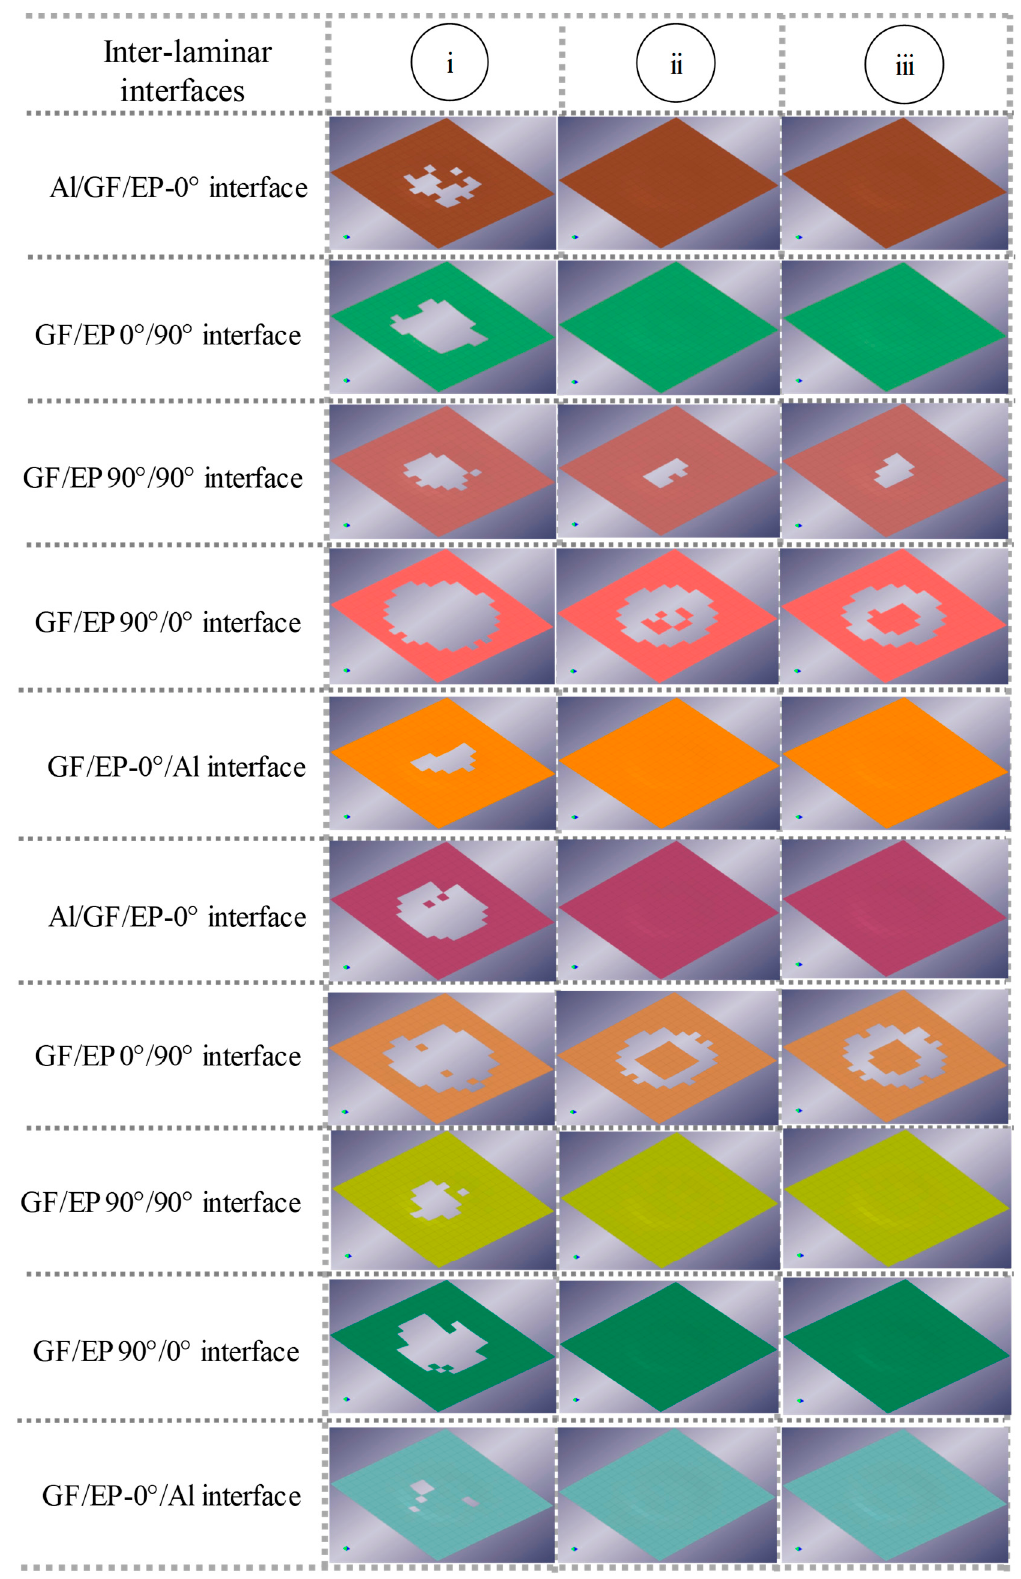
Figure 10. Debonding and delamination of cohesive interfaces of the GLARE laminate ( i ) at room temperature, ( ii ) at 80 °C (39% tougher FM94-epoxy), and ( iii ) at 80 °C (45% tougher FM94-epoxy) at 0.14 ms; the cohesive interfaces are organized from the impacted (top) to the non-impacted (bottom) side.